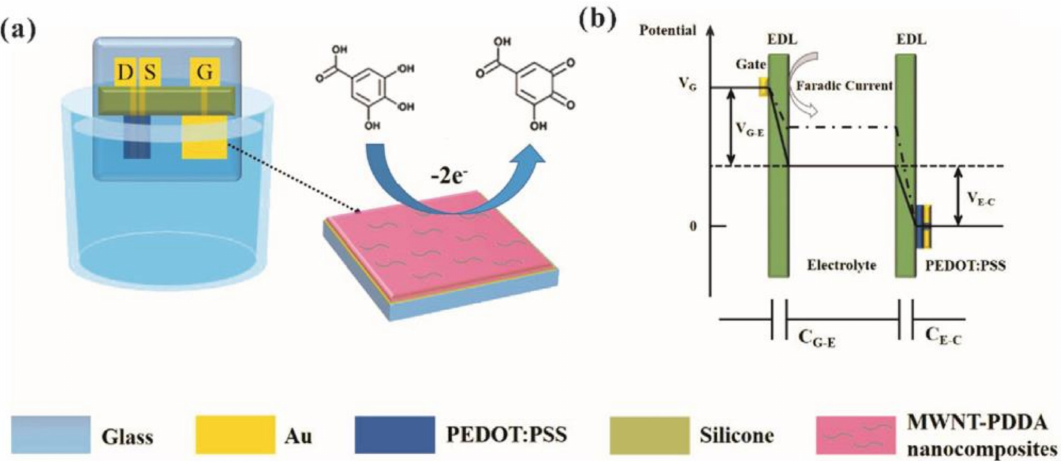
Figure 17. ( a ) The schematic diagram of an OECT-based GA sensor. D, S, and G represent the drain, source and gate electrode, respectively. The oxidation of gallic acid at the CNM-PDDA functionalized gate electrode (on the right). ( b ) Potential drop between the gate and channel of the OECT before (solid line) and after (dashed line) the addition of GA in PBS solution. Reprinted from [109]. Copyright 2017, with permission from